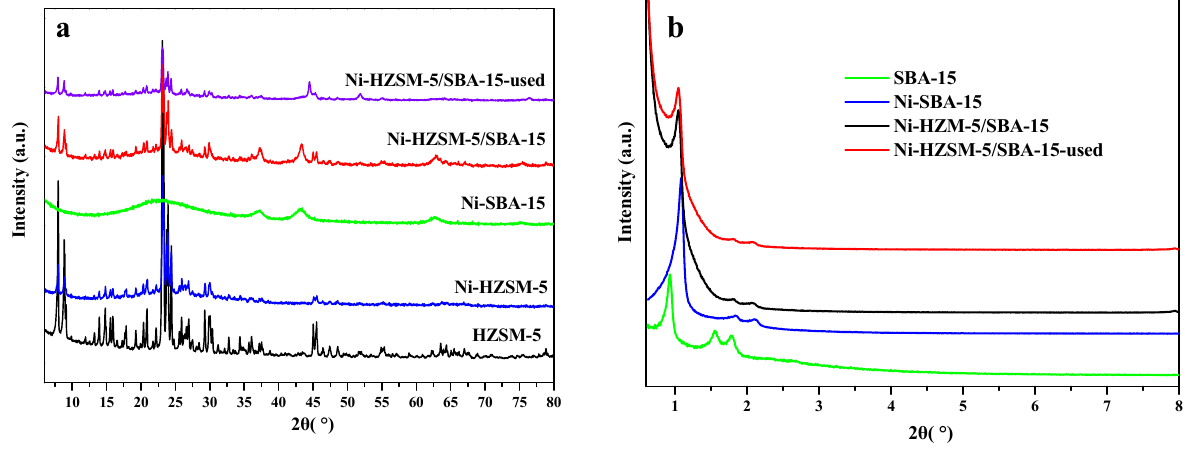
Figure 2. ( a ) Wide-angle XRD patterns of catalysts; ( b ) small-angle XRD patterns of catalysts.